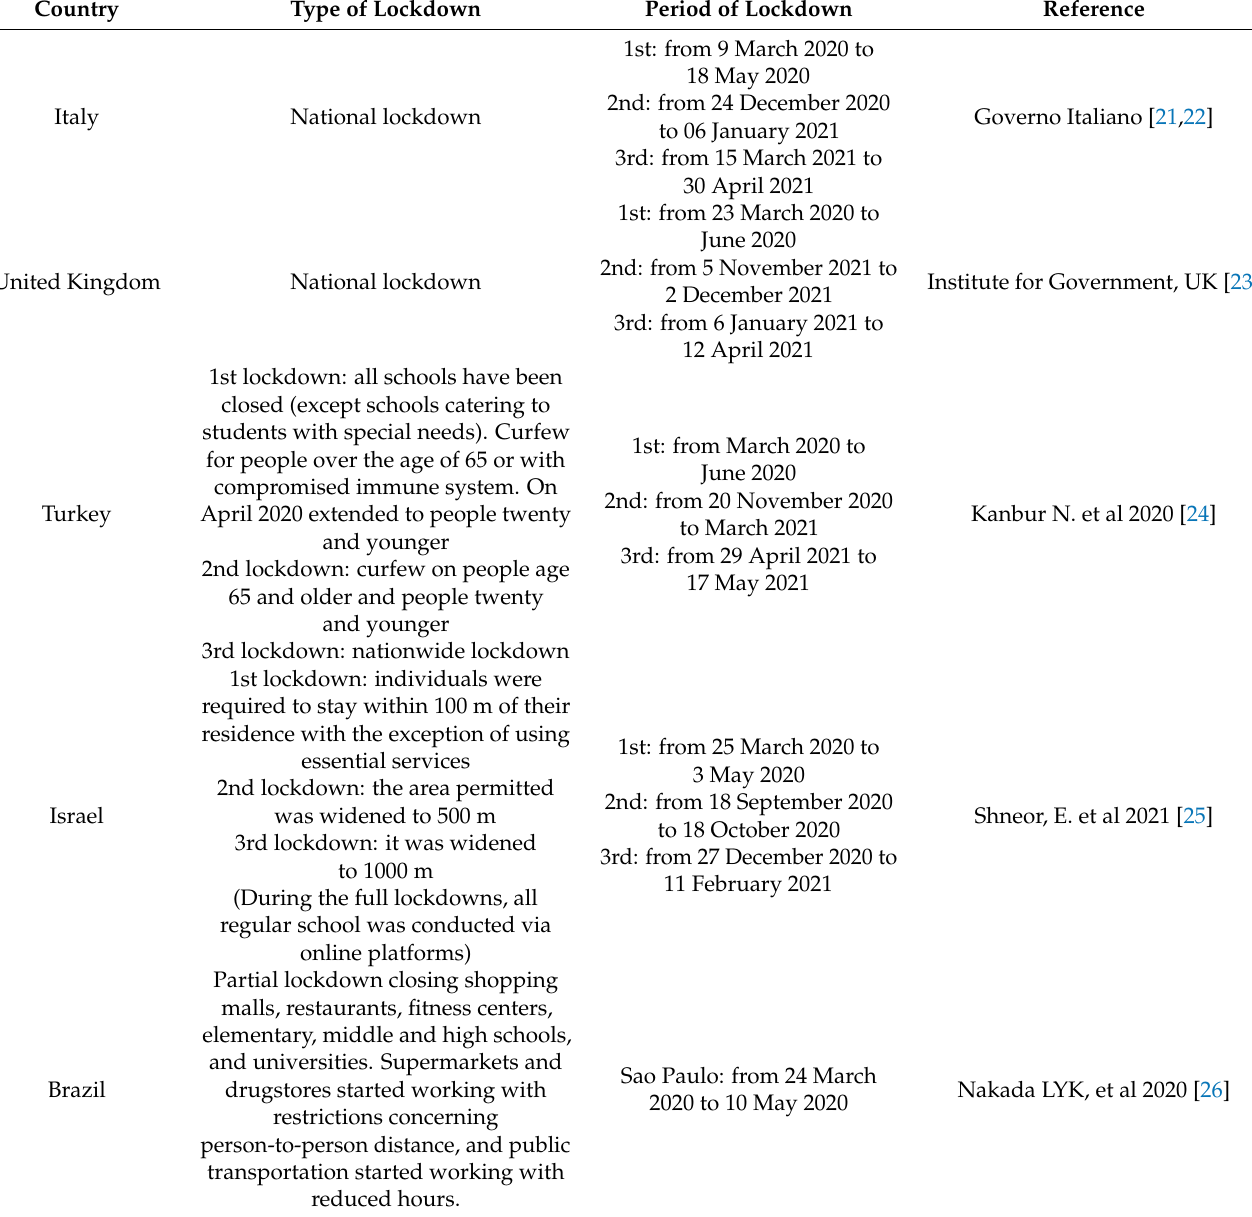
Table 1. The type of lockdown related to the COVID-19 pandemic in different